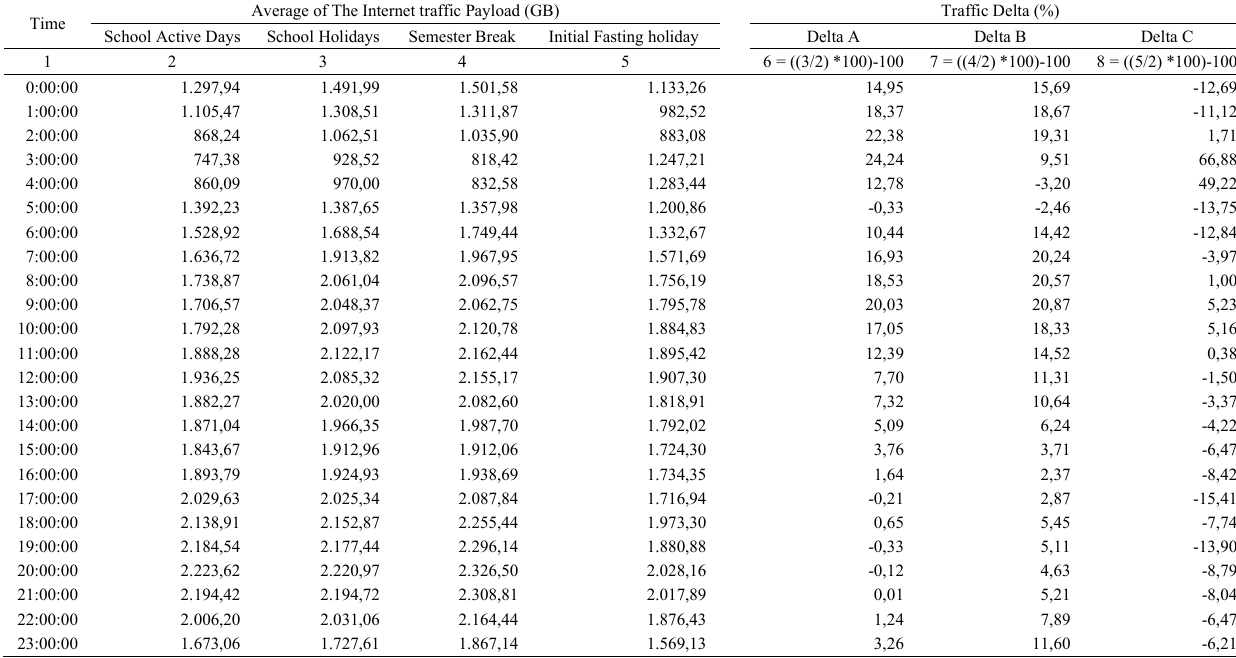
Fig. 8 Slice (a to b) – Dice (a to c) TABLE 3 A VERAGE OF T HE I NTERNET T RAFFIC P AYLOAD AT S CHOOL A CTIVE D AYS , H OLIDAYS , S EMESTER B REAK AND I NITIAL F ASTING H